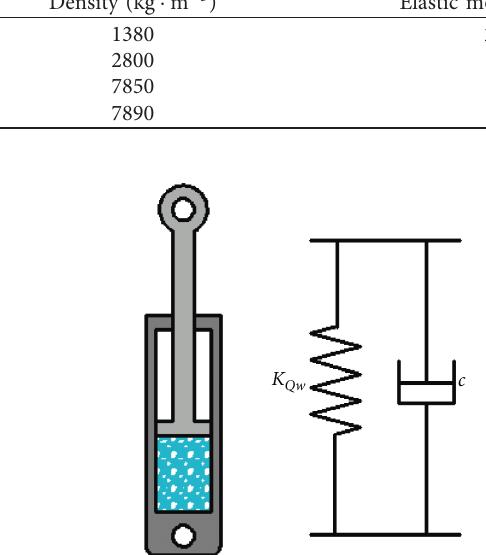
Figure 6 Equivalent spring stiffness of the hydraulic cylinder.